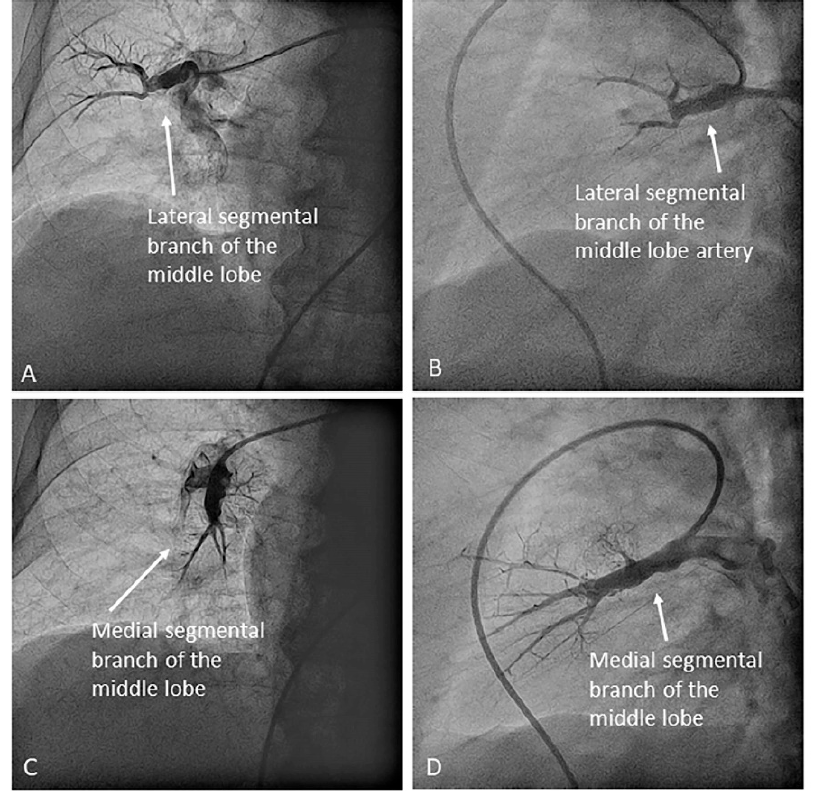
Figure 13. Independent origin of the middle lobe segmental branches in the right interlobar artery: ( A , C ) anteroposterior view and ( B , D ) lateral